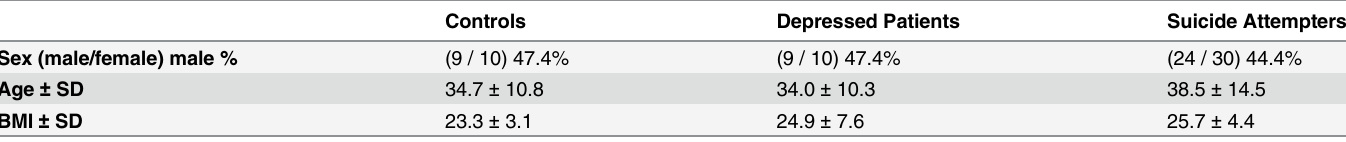
Table 1. The demographic data of the study participants.